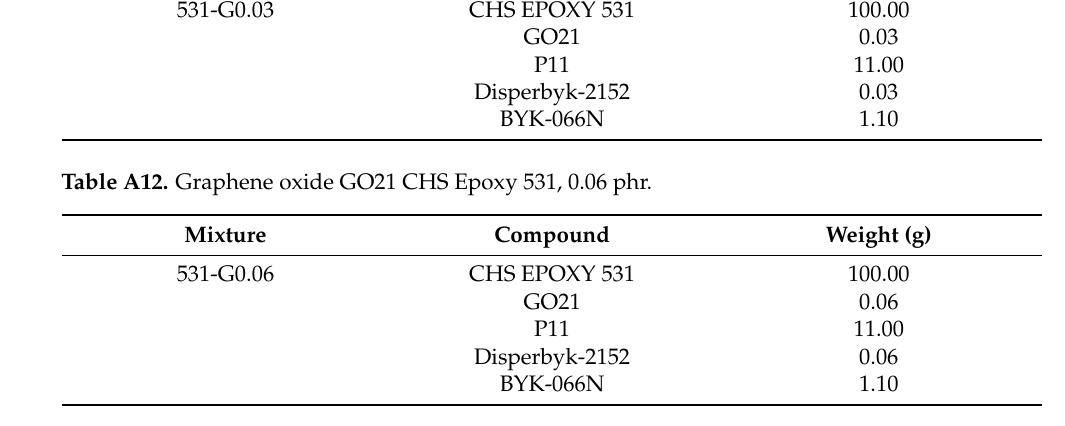
Table A13. Graphene oxide GO21 CHS Epoxy 531, 0.5 phr.